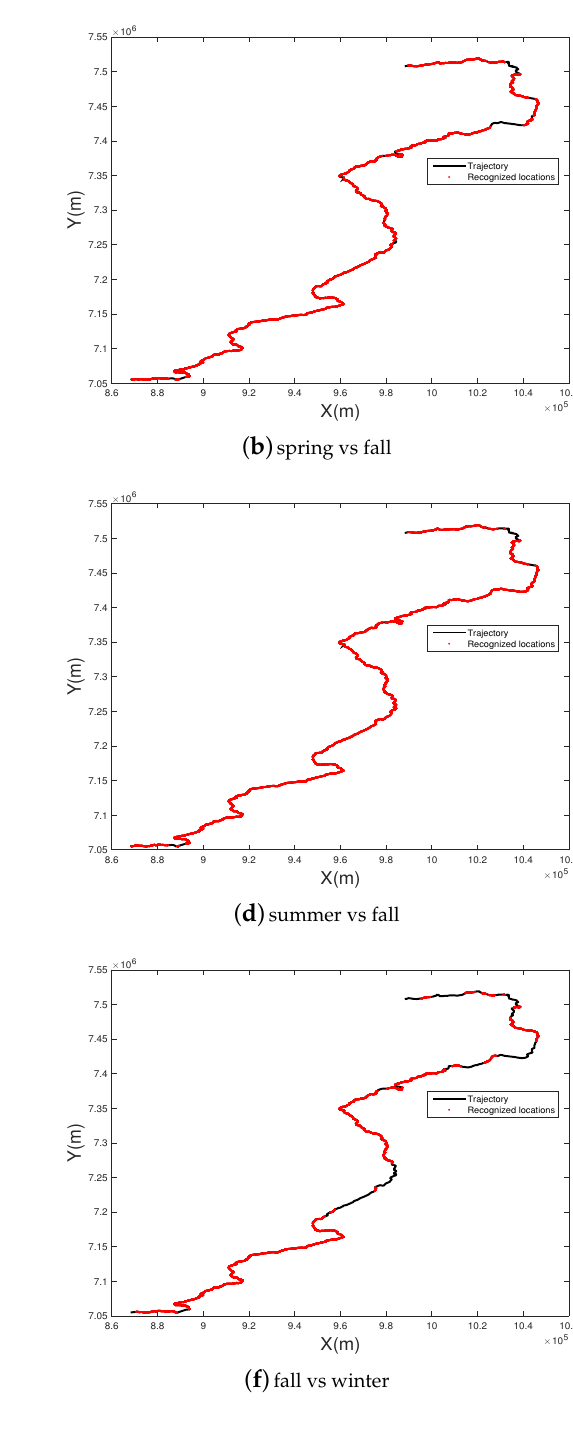
Figure 11. Visual localization results under different season couples at 100% precision level. Successful matched images that come from the same location (on the basis of appearance alone) are marked with red